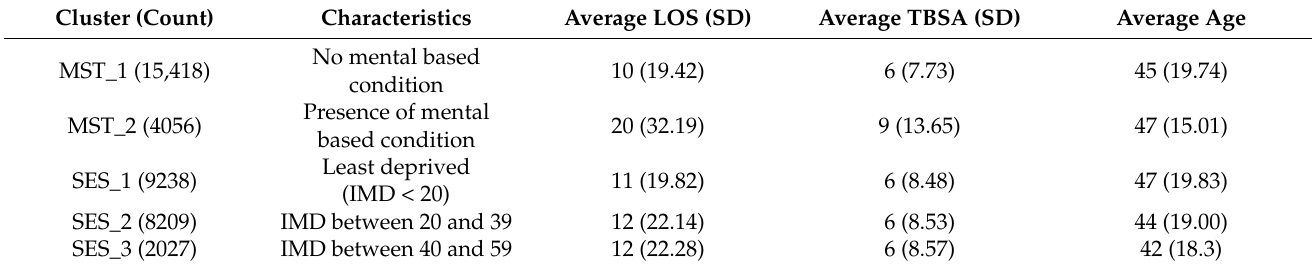
Table 2. Profile of identified clusters by average LOS, TBSA and